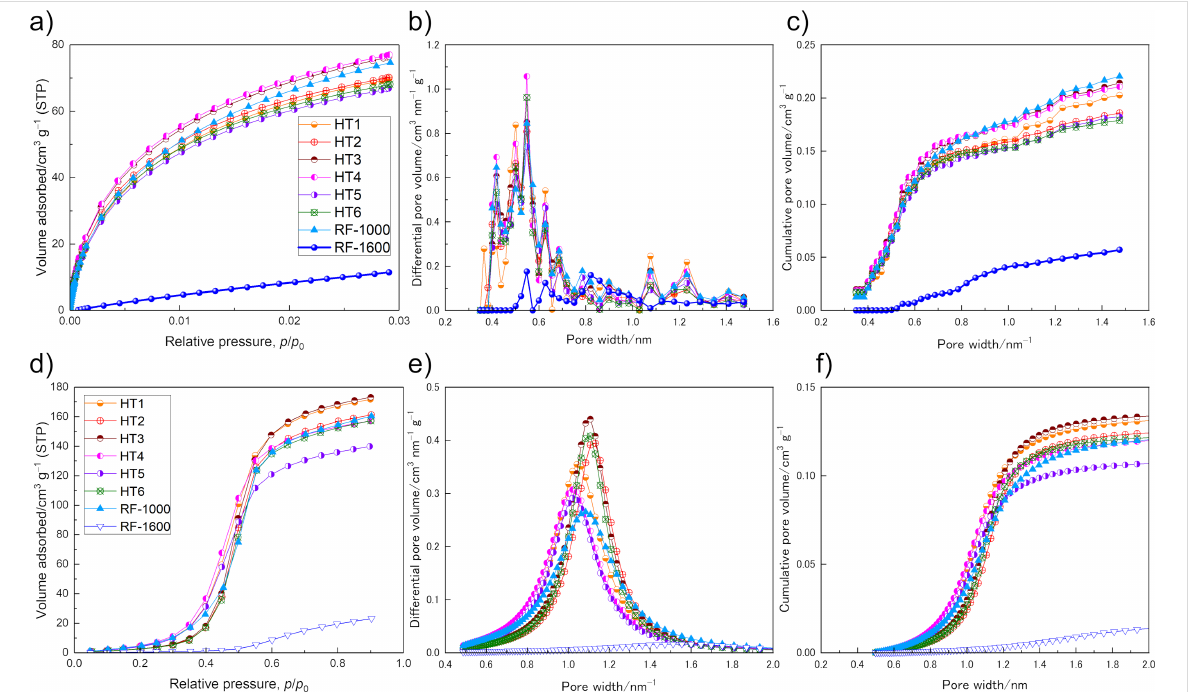
Figure 2: Gas adsorption isotherms (a, d), calculated pore size distributions (b, e), and cumulative pore volumes (c, f) for CO 2 (a–c) and for H 2 O (d–f) adsorption (STP-standard pressure).